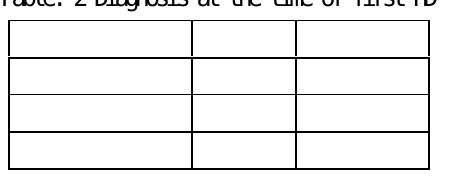
The common causes of ESRD were chronic glomerulonephritis (CGN) and chronic interstitial nephritis (CIN). They constitute 55.5% (n=15) of cases. Diabetic nephropathy was placed third (30%). Obstructive uropathy and renal transplant rejection constituted the rest (14.5%).